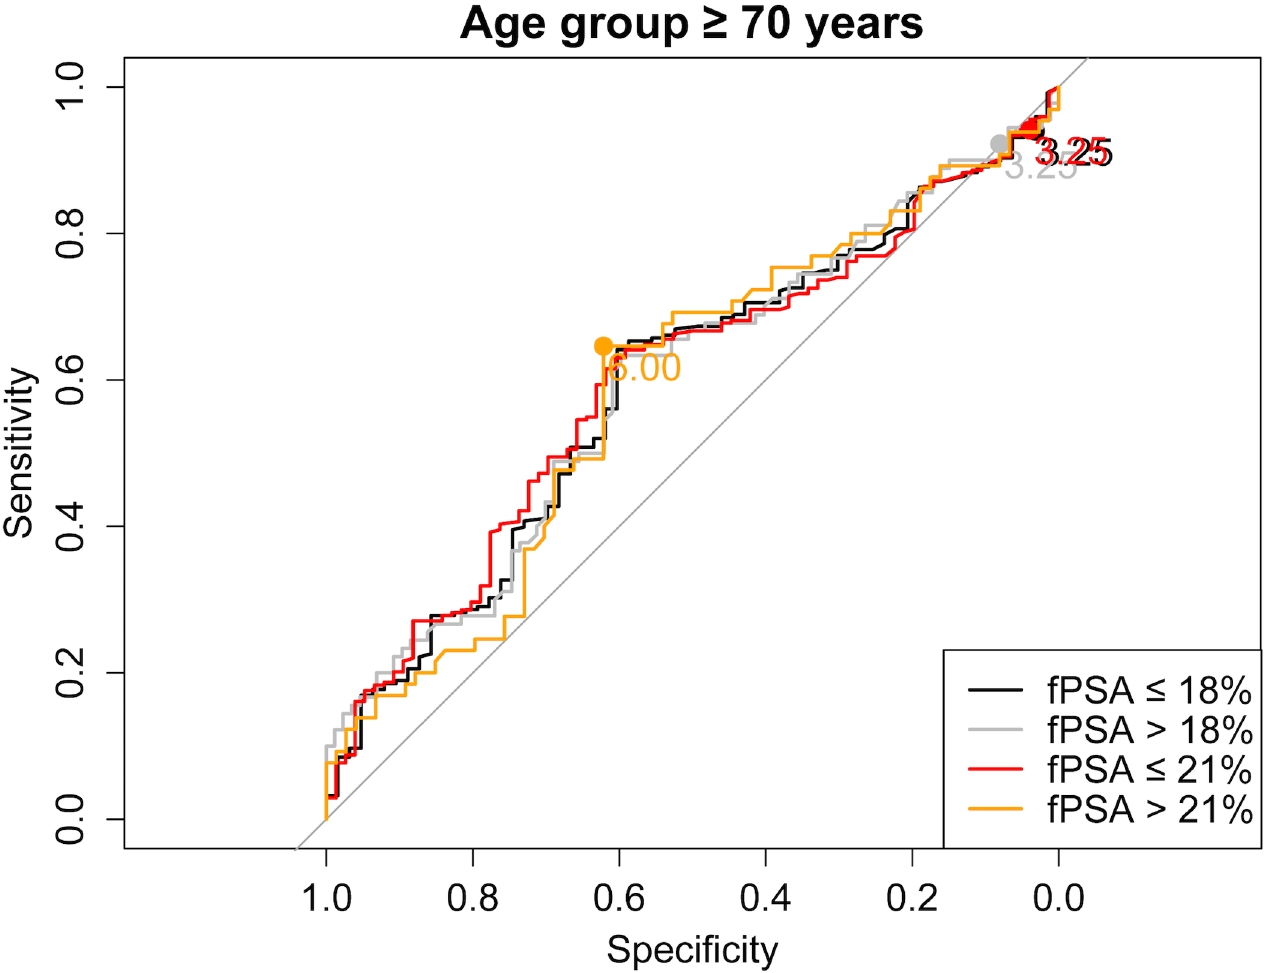
Fig 4. ROC curve for the age group (cid:3) 70 years stratified for fPSA values (cid:1) 18% vs. > 18% and (cid:1) 21% vs. > 21%, respectively.